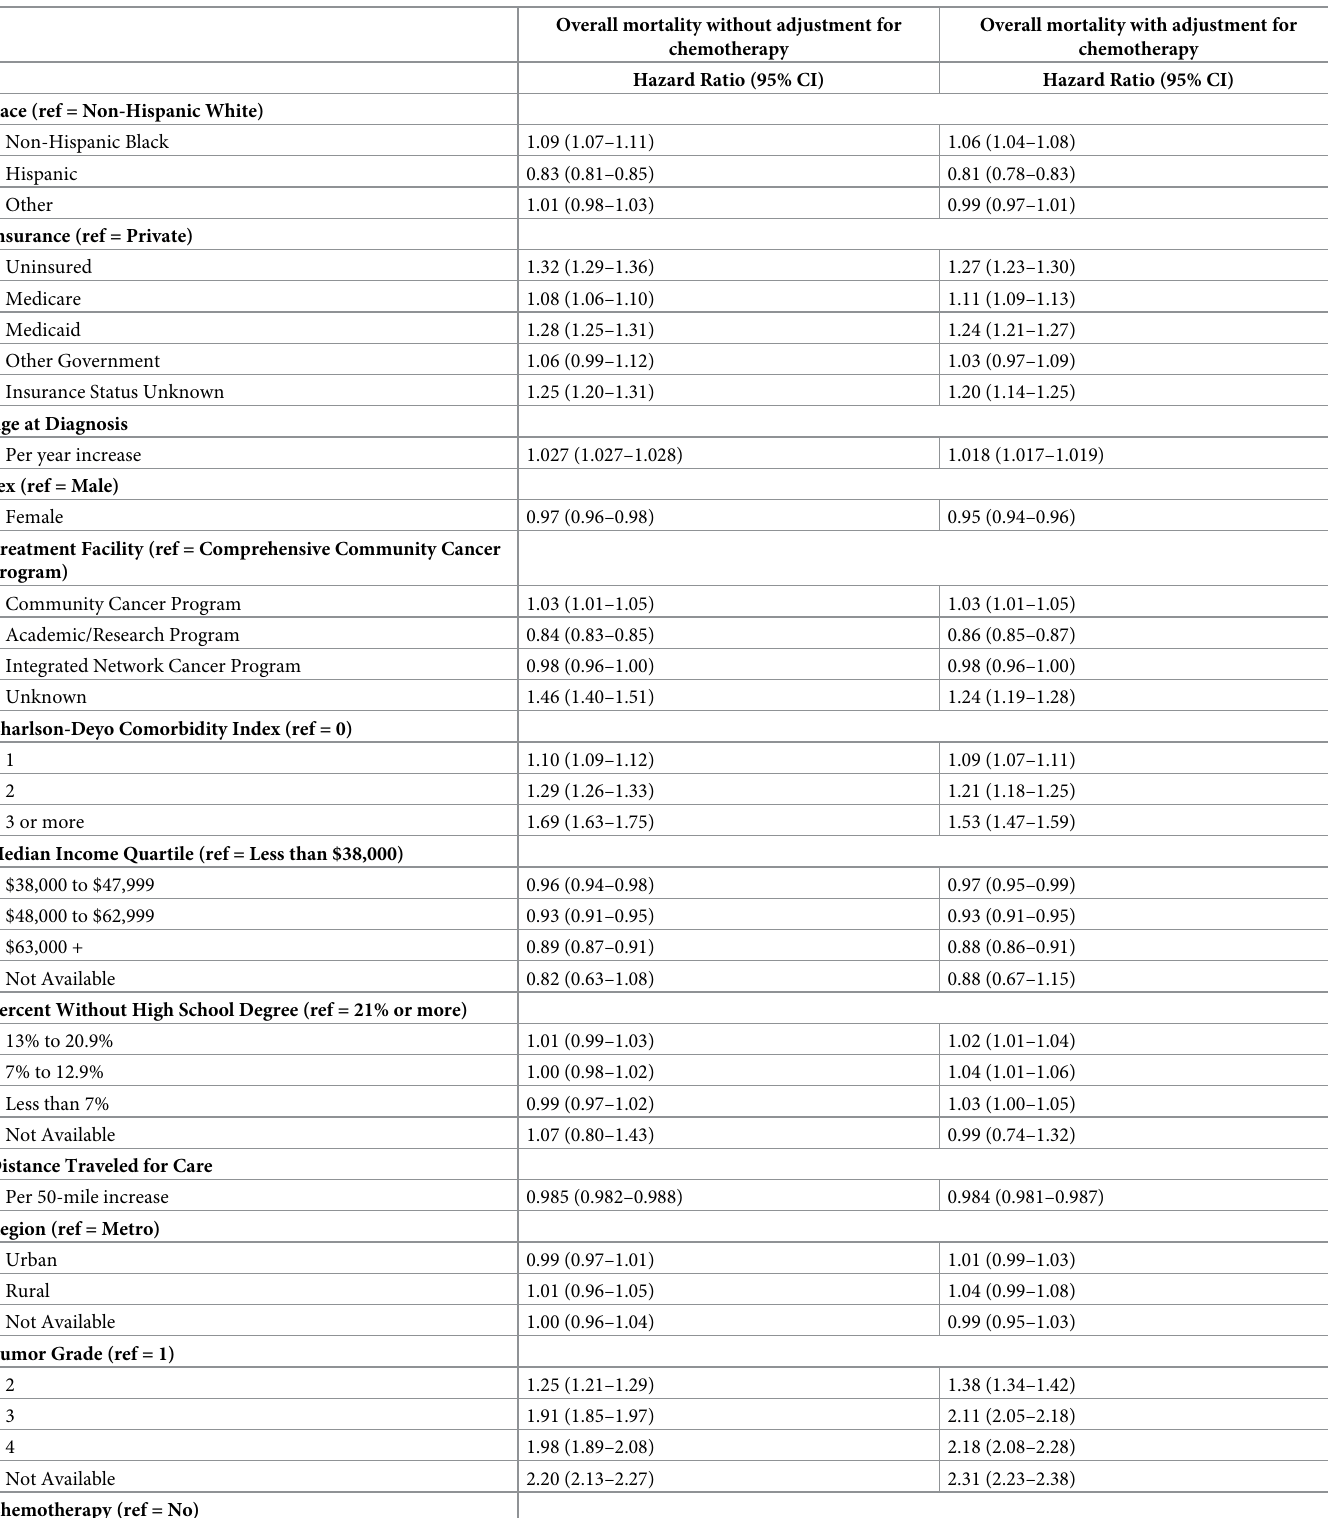
Table 4A. Multivariable Cox hazards main effects model for all-cause mortality with and without adjustment for receipt of